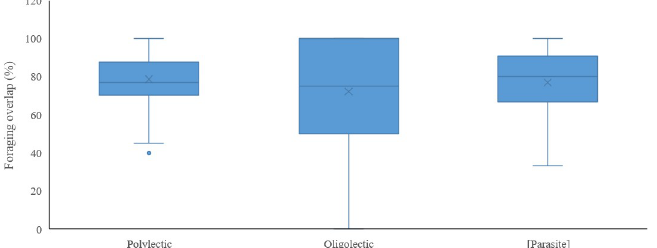
Fig 3. Box-plot of different functional groups of wild bees and their foraging overlap with honey bees. The honey bee and wild bees with no recorded forage plants are excluded.